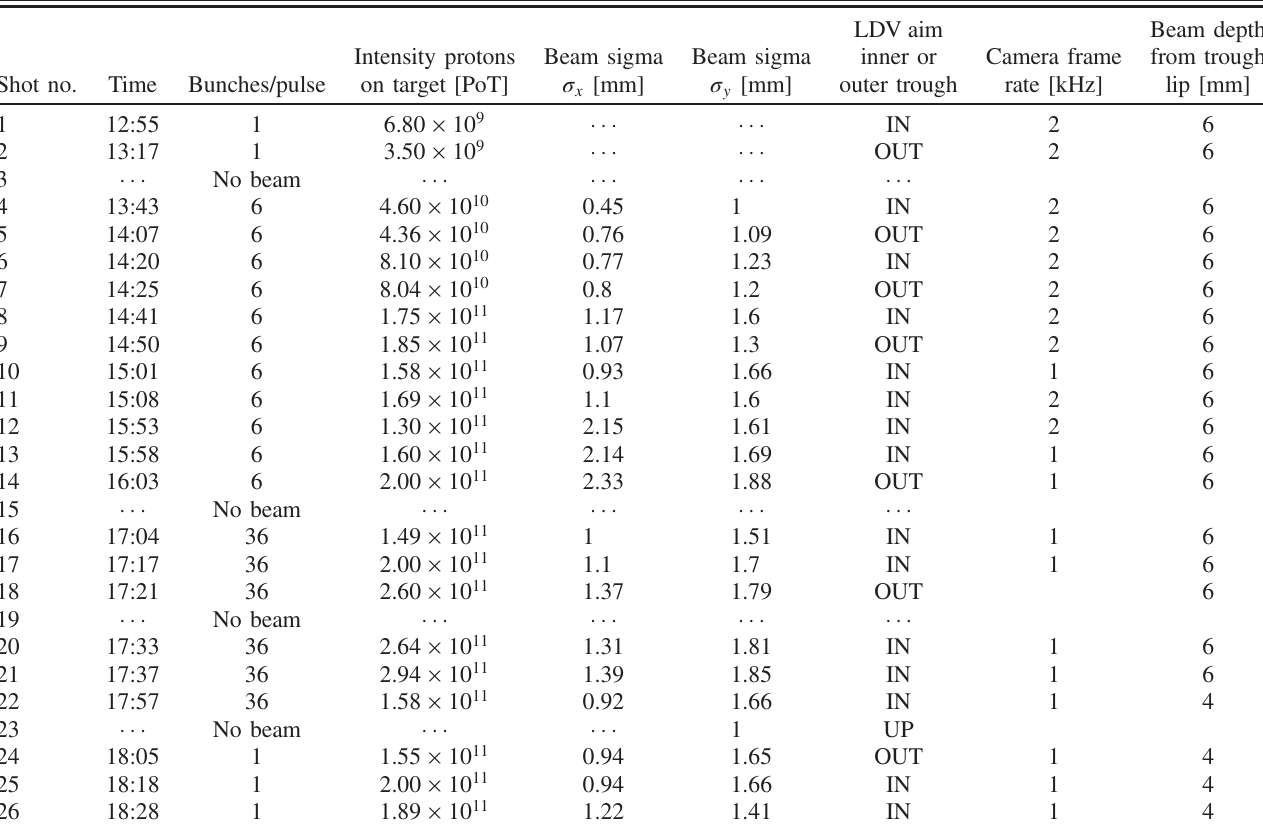
TABLE I. List of extracted beam pulses to the experiment. For the three empty shots, the beam was dumped into the SPS and not extracted to the experiment.